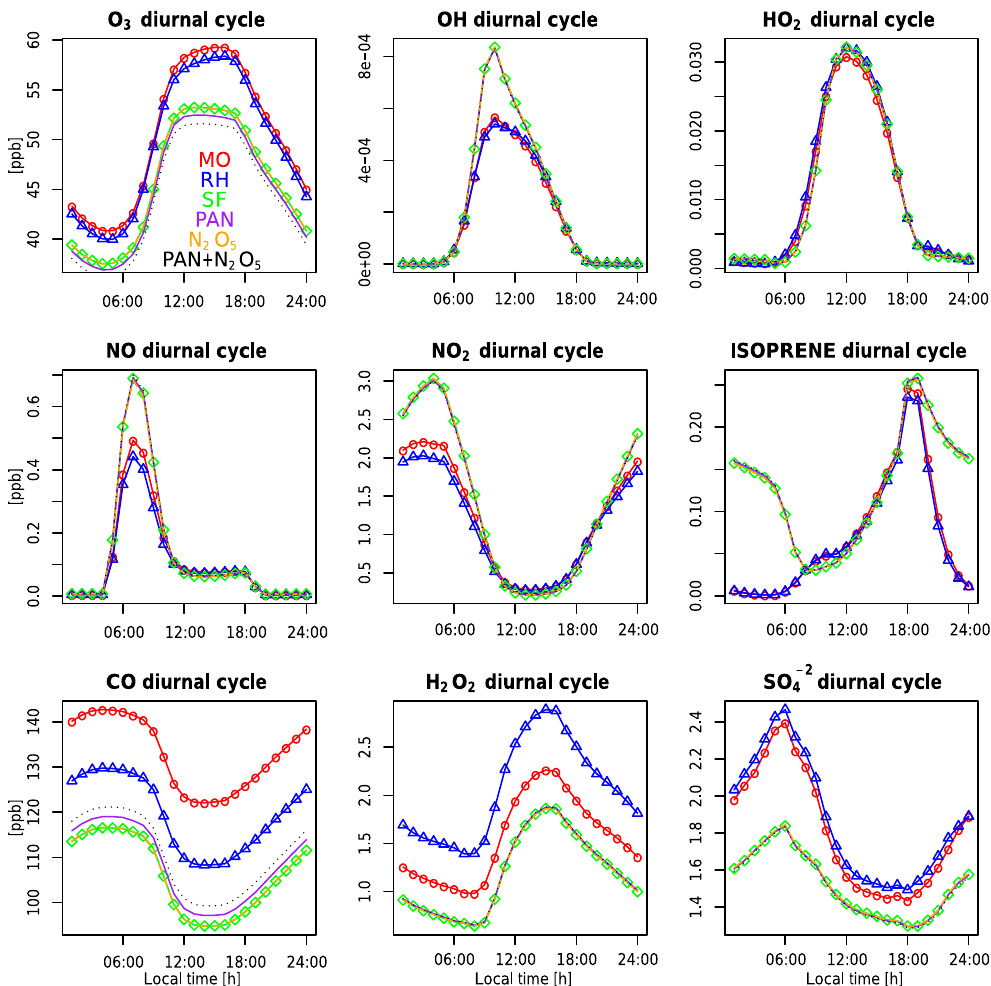
Figure 9. Example diurnal time series for various species for MO (red circles), RH (blue triangles), and SF (green diamonds) averaged over a single grid cell in the central US (100 ◦ west and 47 ◦ north). The units are in ppb. Also included are three sensitivity tests conducted with the SF mechanism: adding PAN chemistry (purple), adding N 2 O 5 chemistry (orange), and adding both PAN and N 2 O 5 chemistry